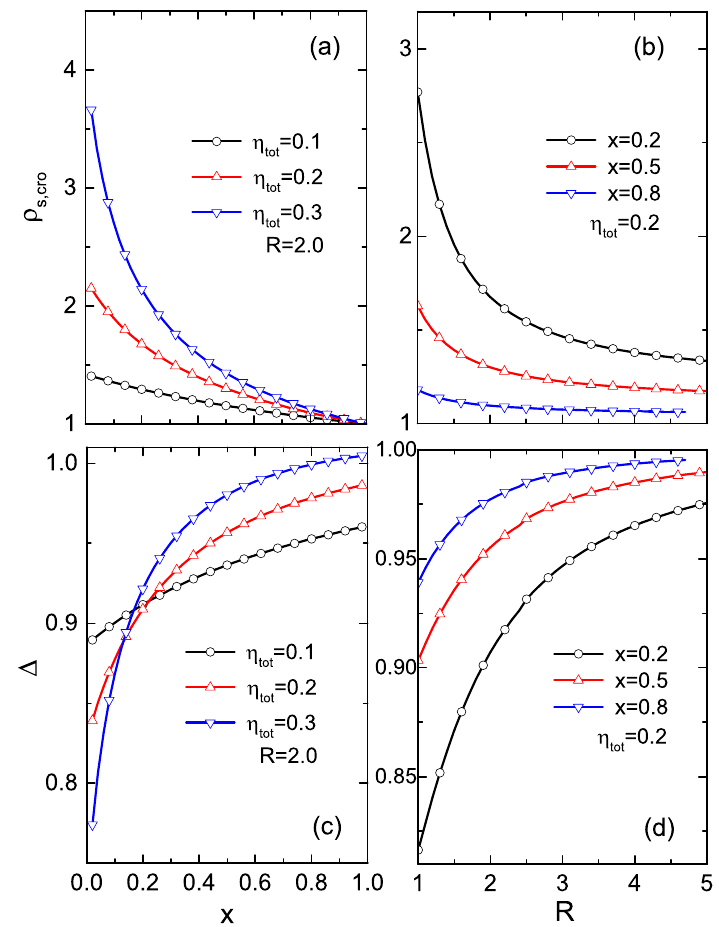
Figure 3. ( a , c ) correspond respectively the x dependence of ρ s , cro and ∆ under different conditions of η tot . ( b , d ) correspond respectively the R dependence of ρ s , cro and ∆ under different conditions of x . Note that the symbols in the figure is used to guide eyes.